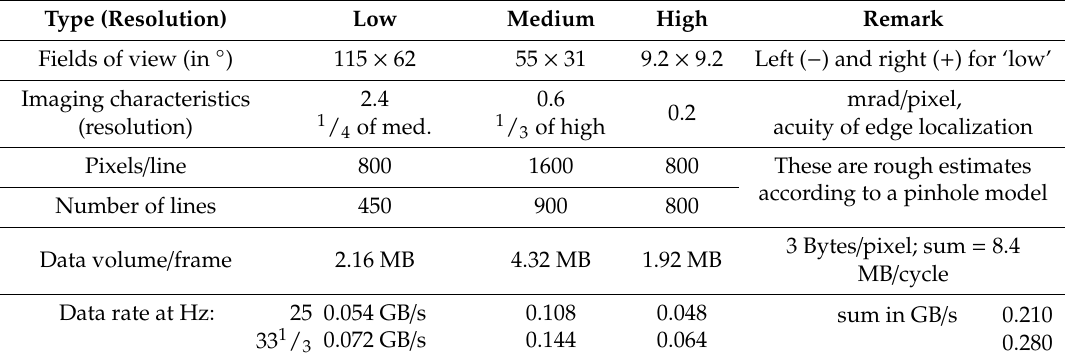
Figure 15. ‘Vehicle eye’ with a tri-focal set of four cameras: two times 115° FoV with low resolution, 55° with medium and 9.2° with high resolution. Table 1. Parameters of a gaze-controllable ‘vehicle